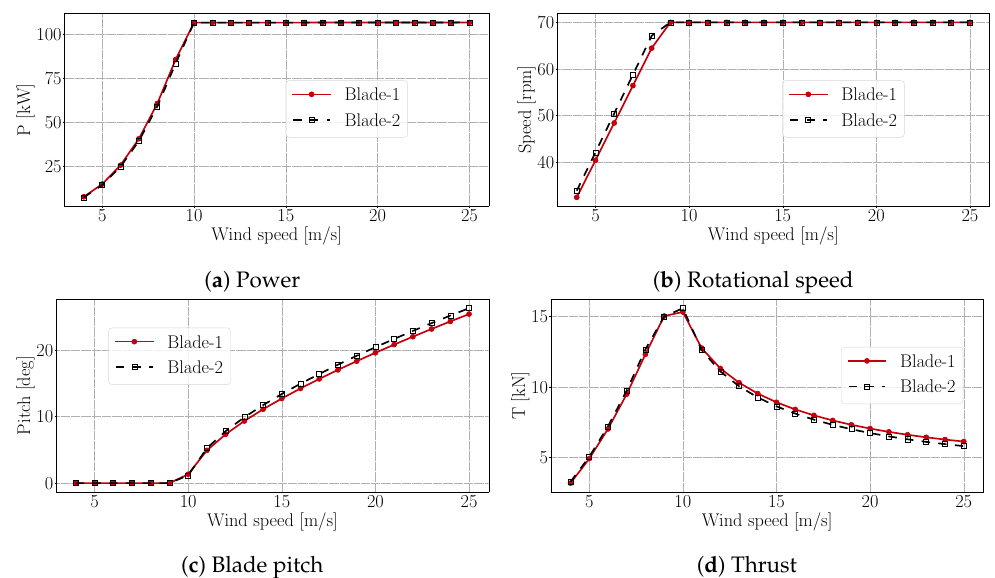
Figure 12. Power ( a ), rotational speed ( b ), pitch ( c ), and thrust force ( d ) of baseline and optimized design of the blades for different wind